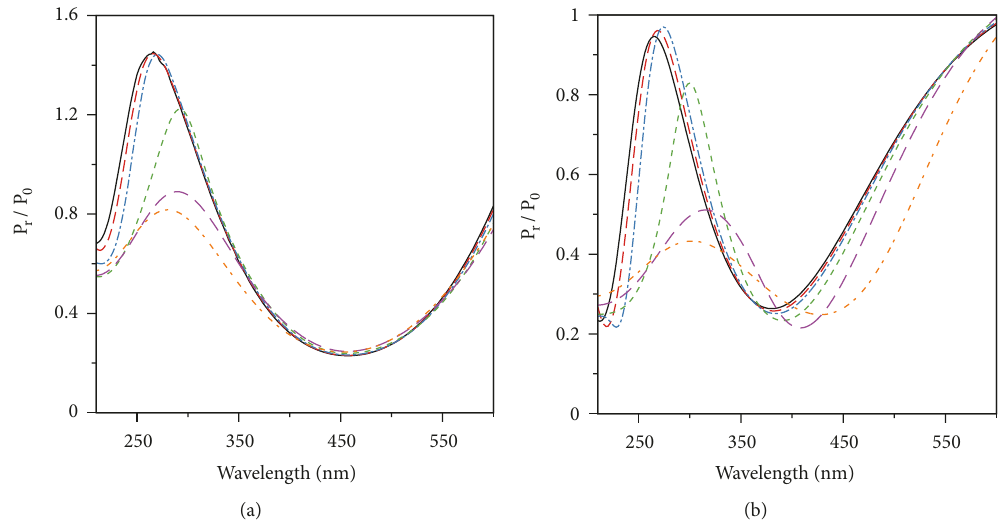
Figure 2: Normalised power radiated by spherical particles on top of a substrate, illuminated by an electric dipole. For substrates comprised of (a) Al and (b) SiO 2 . All curves correspond to the same volume fractions indicated in Figure 1.